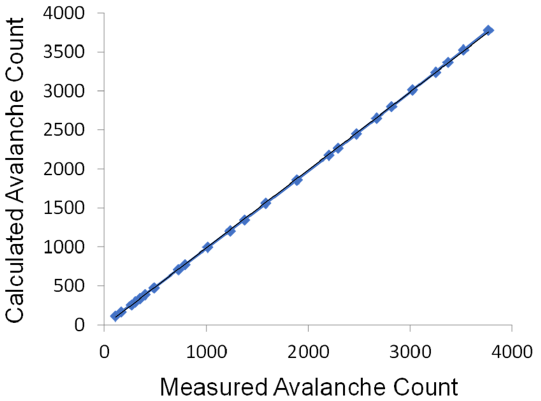
Figure 5. Comparison of avalanche count calculated by Equation (10) with observed avalanche count by discrete measurement of n m , 1 ≤ n m ≤ 4. All instrumental parameters were experimentally determined and are presented in Supplementary Materials (Table S1). The comparison line has a slope of 1.000 (ideal fit = 1.000) and an R 2 value of 0.9999.